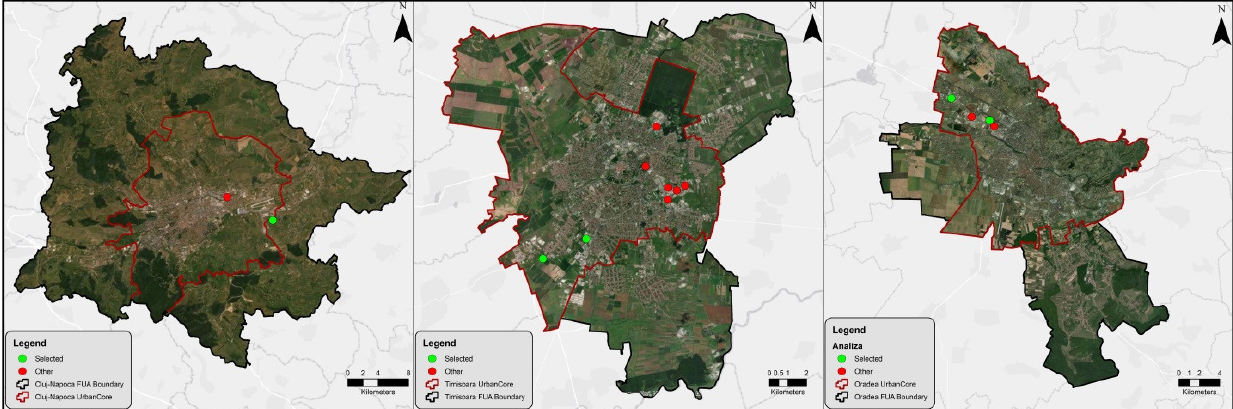
Figure 8. Seveso sites comprised within the study areas: Cluj-Napoca ( left ), Timis Oradea ( right